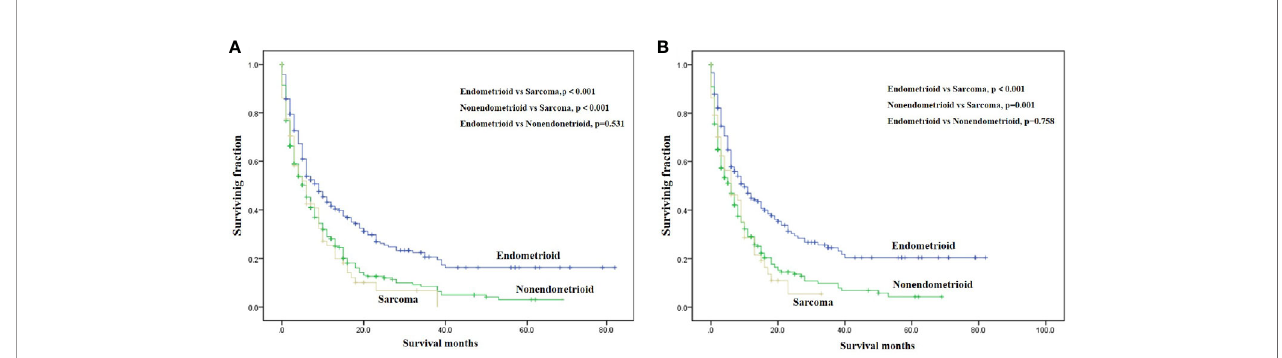
FIGURE 1 | Kaplan-Meier method estimated OS (A) and CSS (B) in endometrial cancer bone metastasis strati fi ed by tumor subtype. (OS, overall survival; CSS, cancer-speci fi c survival).